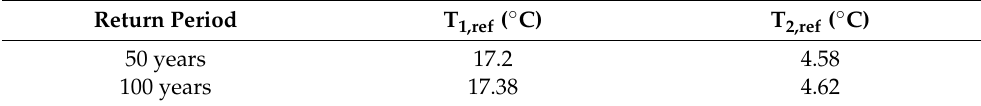
Table 3. Temperature difference representative value of T 1,ref and T 2,ref (beam height 450